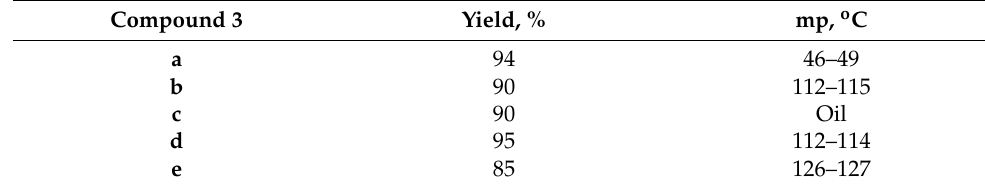
Table 1. Yields and melting points of amfens 3 .